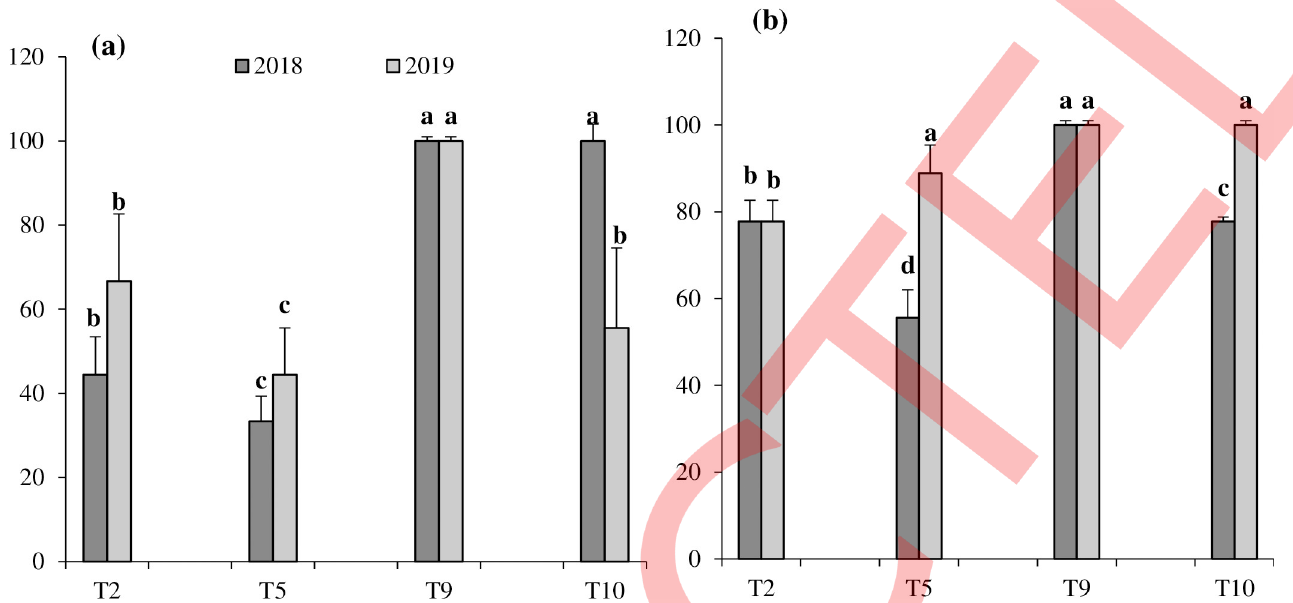
Fig 6. Frequency percentage of horse purslane at 30 (a) and 45 (b) days after emergence in soybean field. T 2 : Horse purslane-free till 20 DAE, T 5 : All weeds-free till 20 DAE, T 9 : Weedy check horse purslane only, T 10 : Weedy-check all